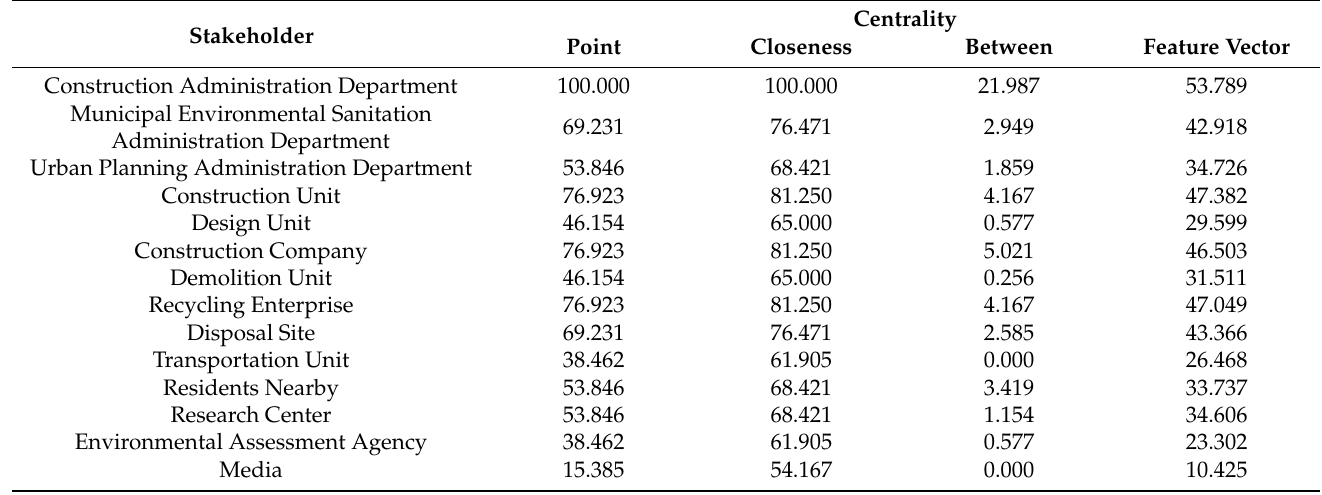
Table 6. Analysis on Network